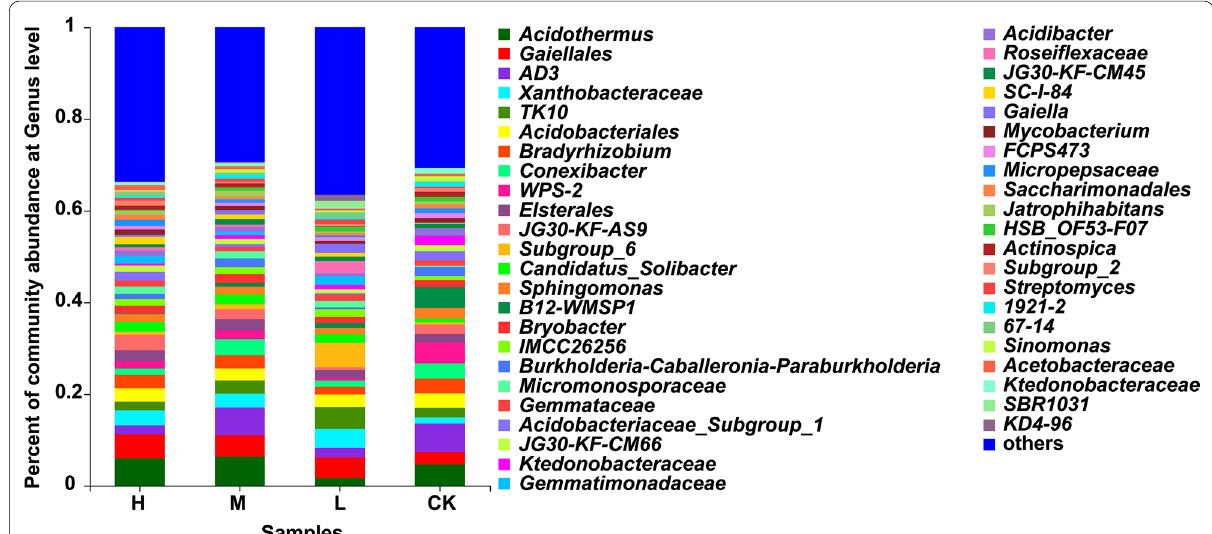
Fig. 2 Compositions of soil bacterial communities at genus level under four N application treatments. H: high N application in the sugarcane soil (964 kg ha − 1 ), M: medium N application in the sugarcane soil (482 kg ha − 1 ), L: low N application in the sugarcane soil (96 kg ha − 1 ), CK: no N